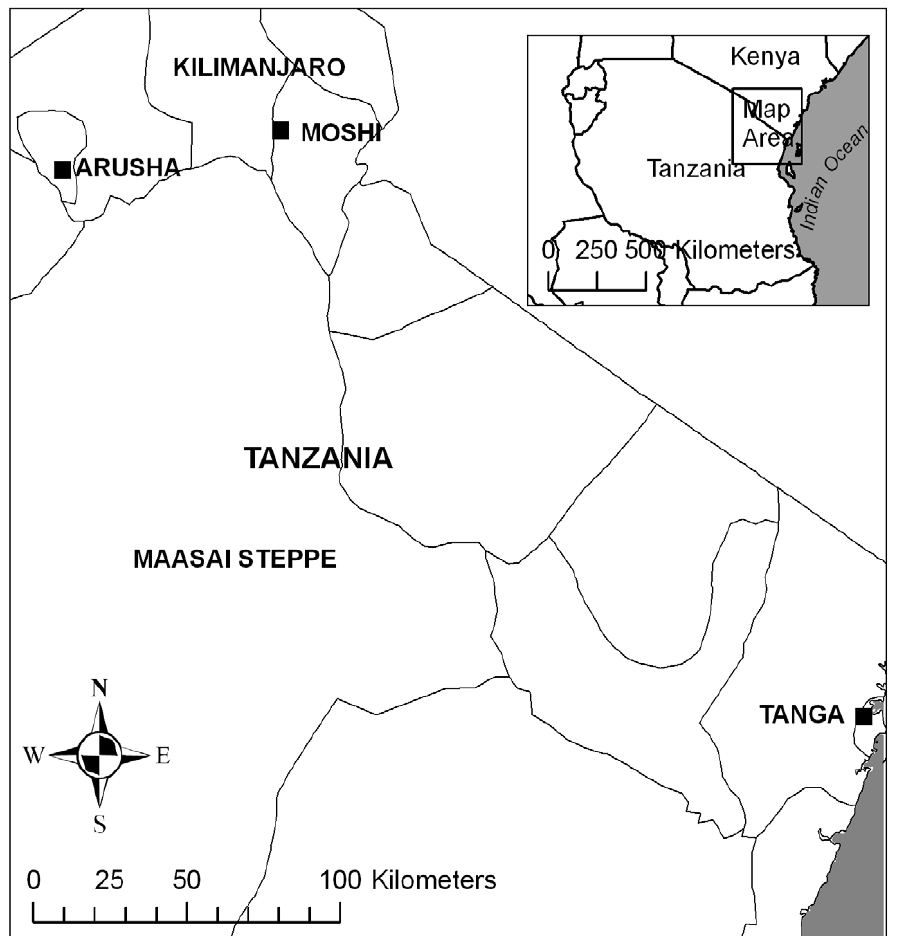
Figure 1. Map of study area in north eastern Tanzania.